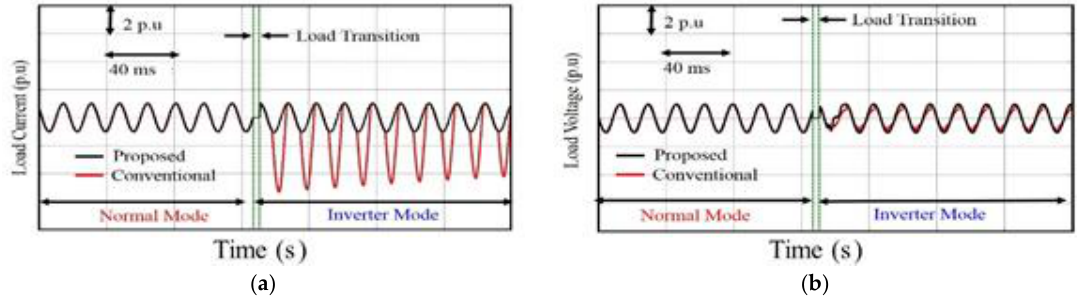
Figure 15. ( a ) Load current; and ( b ) load voltage for the conventional and proposed single-phase offline UPS topologies when the inverter voltage is injected at 90°.